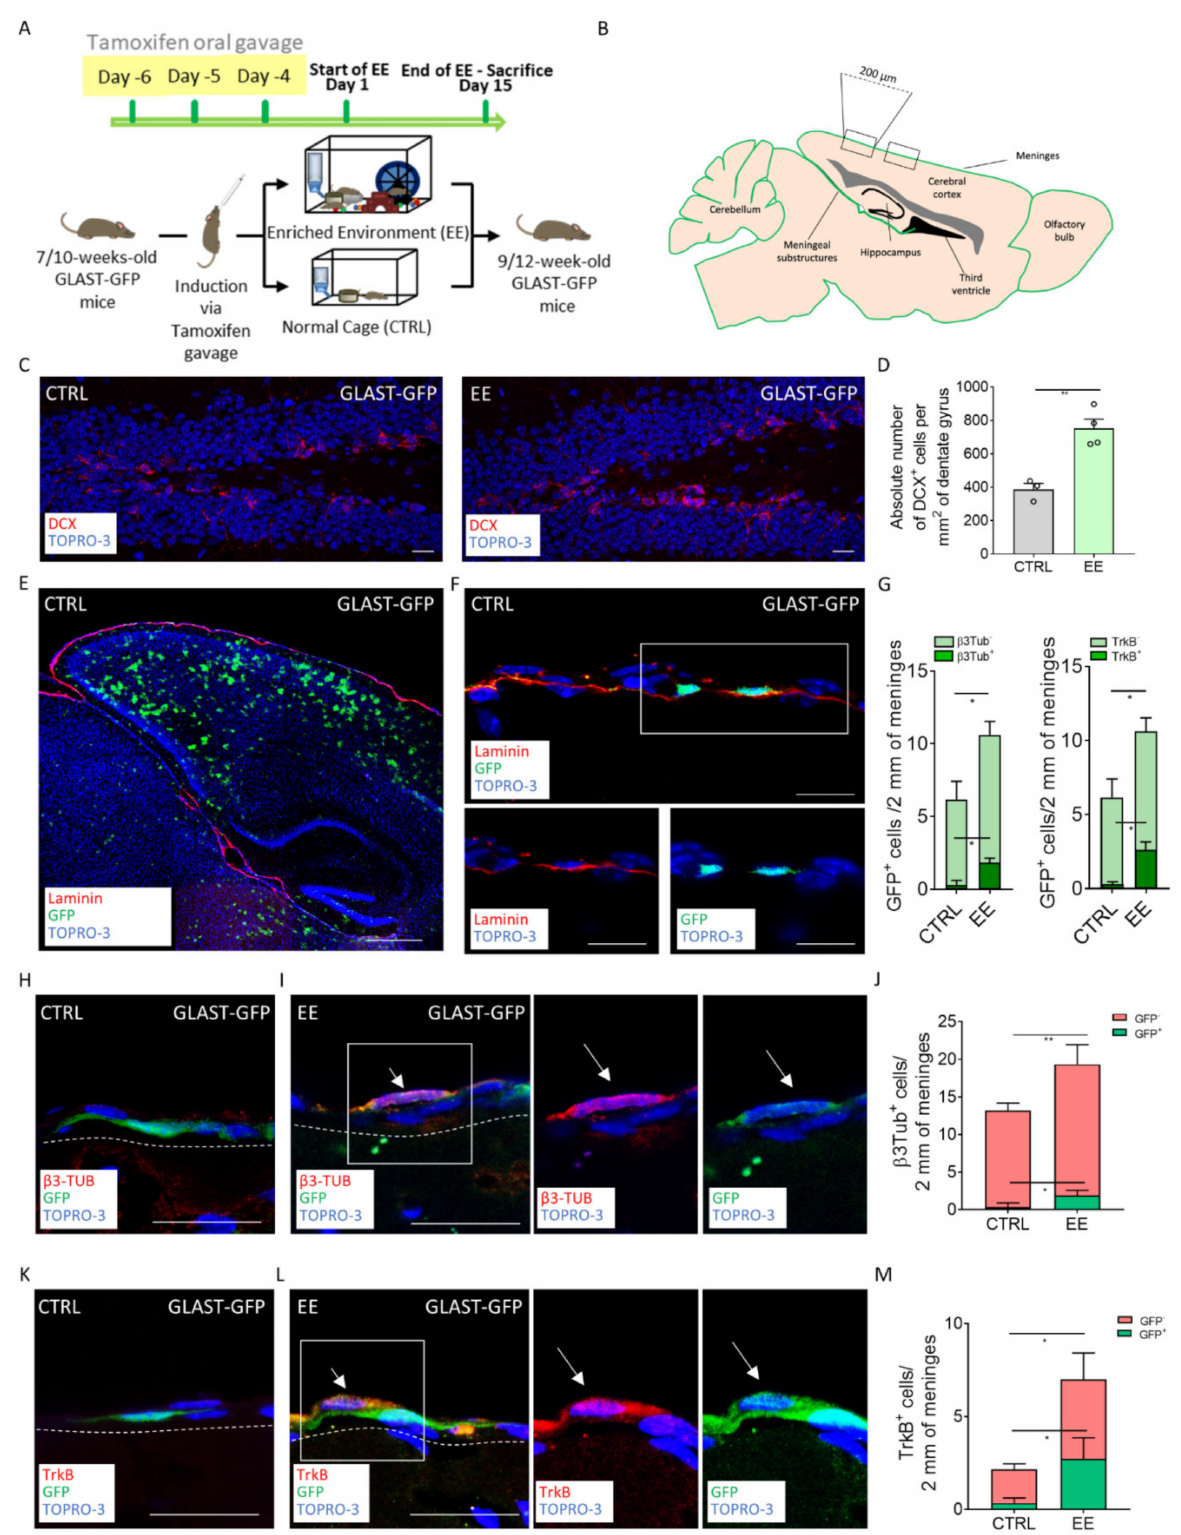
Figure 2. Lineage tracing confirms the radial glial origin of the EE-induced immature neurons. ( A ) Schematic representation of the experimental design used for EE exposure for the GLAST-GFP mice. ( B ) Scheme depicting the sagittal section of a mouse brain, highlighting the specific regions where the brain external meninges were analyzed. ( C ) Sagittal brain section of GLAST-GFP mice, showing hippocampal DCX + (red) cells in the CTRL and EE mice. ( D ) Graph showing the number of DCX + cells per mm 2 of the dentate gyri (DG) in the CTRL and EE animals. ( E ) Sagittal brain section of the